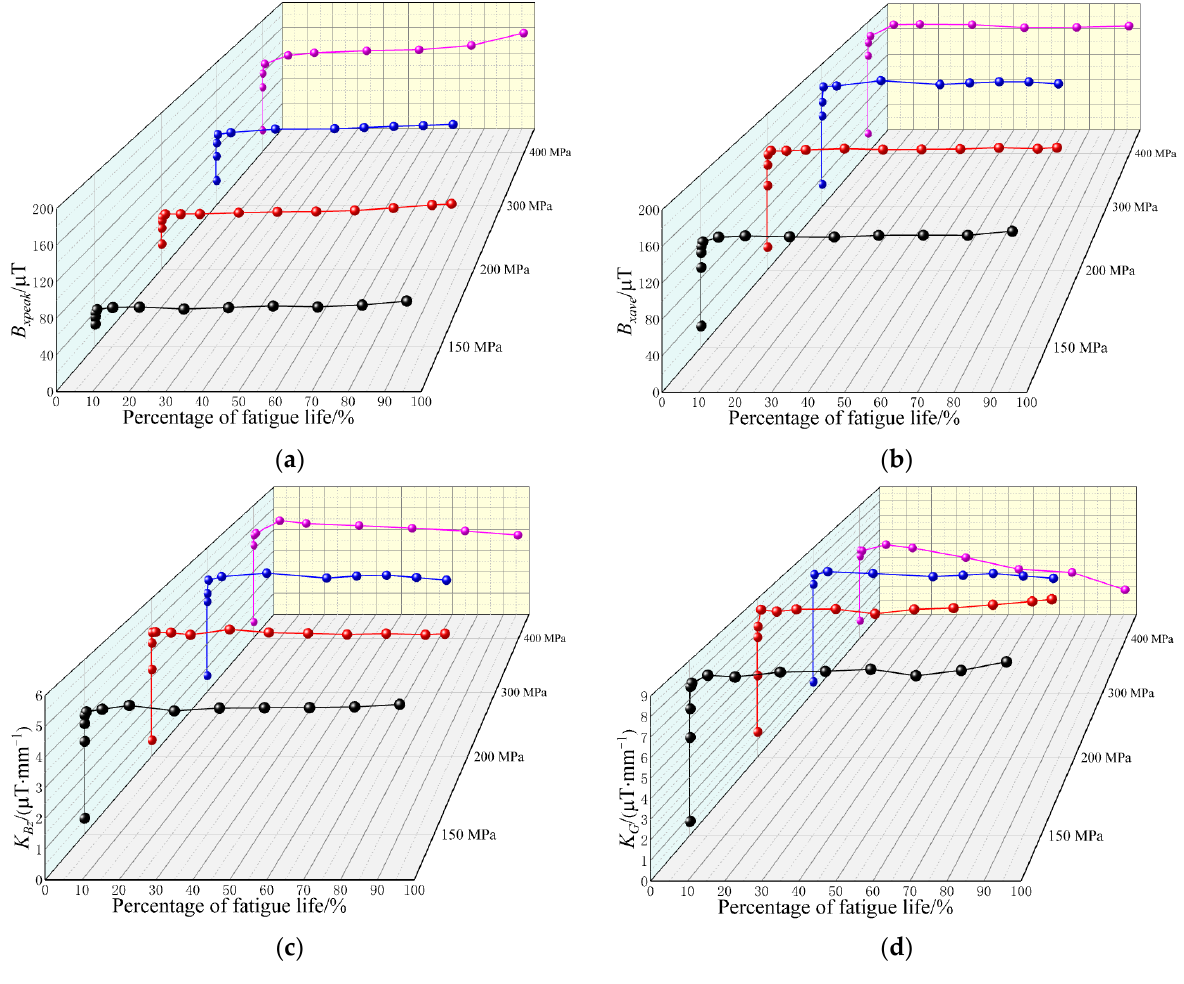
Figure 6. Characteristic variations of MMMT signals during the fatigue tests ( a ) B xpeak ; ( b ) B xave ; ( c ) K B ; ( d ) K G z